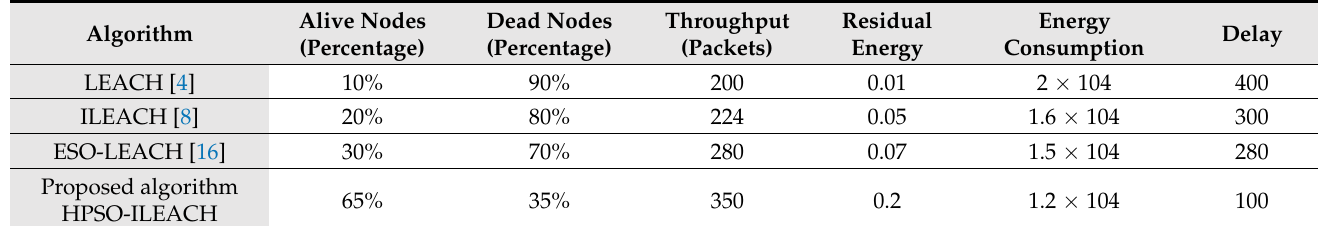
Table 4. Simulation result